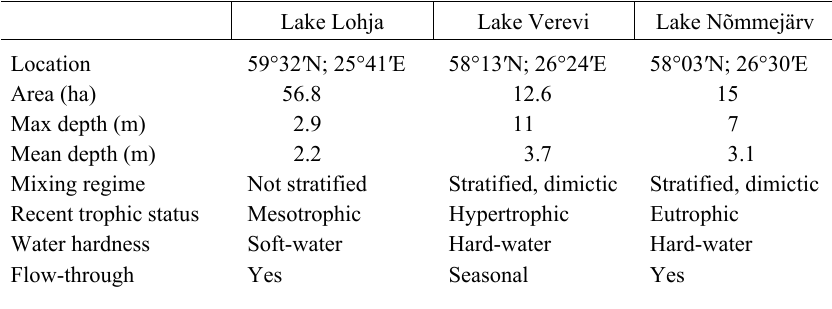
Table 1. Main parameters of the studied lakes Lake